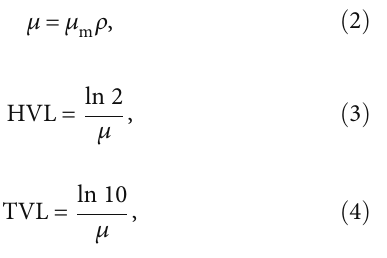
Figure 1(c). Rectangular molds of